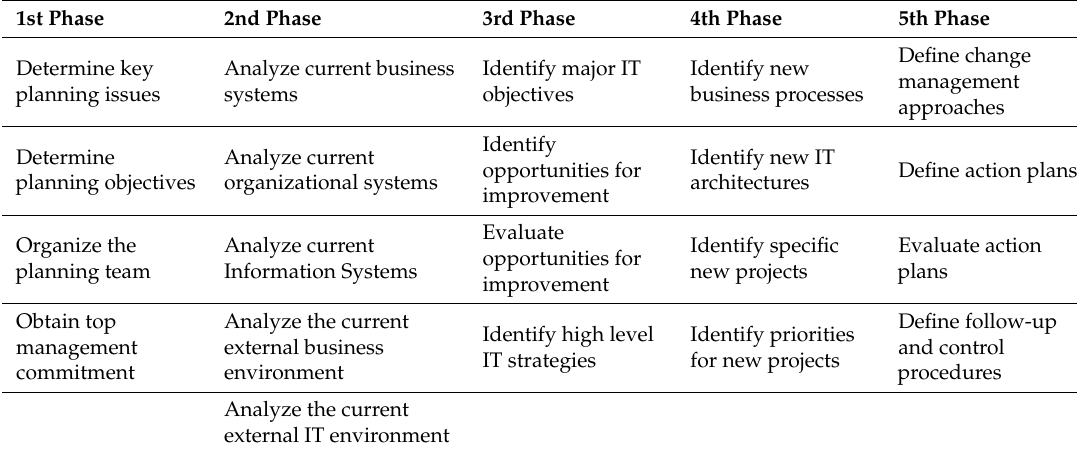
Table 1. Strategic Information Systems Planning (SISP) phases and activities.